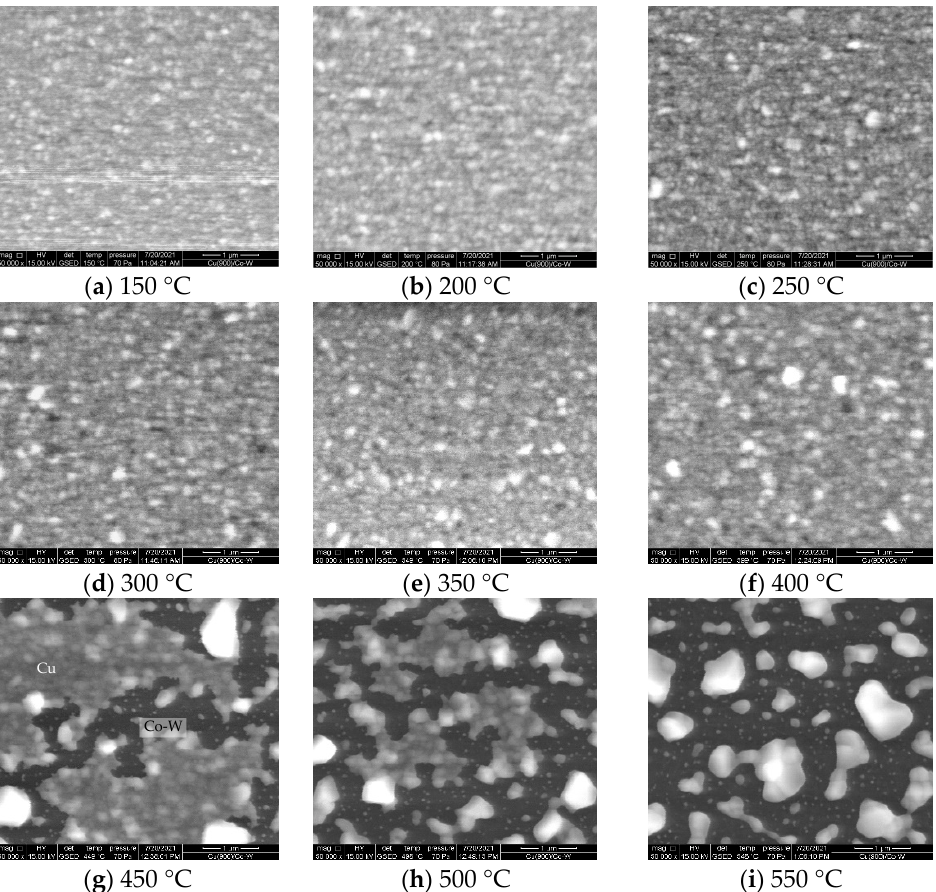
Figure 1. Surface of the Cu film deposited over a Co-W layer from 150 °C ( a ) to 550 °C ( i ), using a 10 °C/min heating rate. The figures illustrate the progressive microstructural variation with temperature increases of 50 °C.